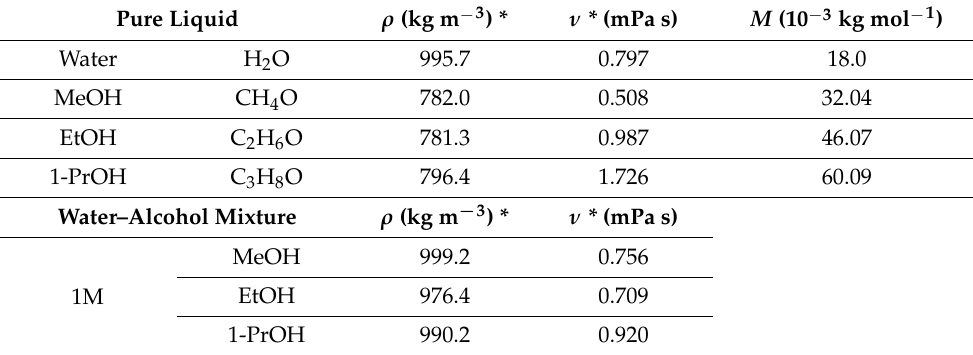
Table 2. Density ( ρ ), viscosity ( ν ), and molar mass ( M ) of the used pure liquid, and density ( ρ ) and viscosity ( ν ) of the used water–alcohol mixtures at 303